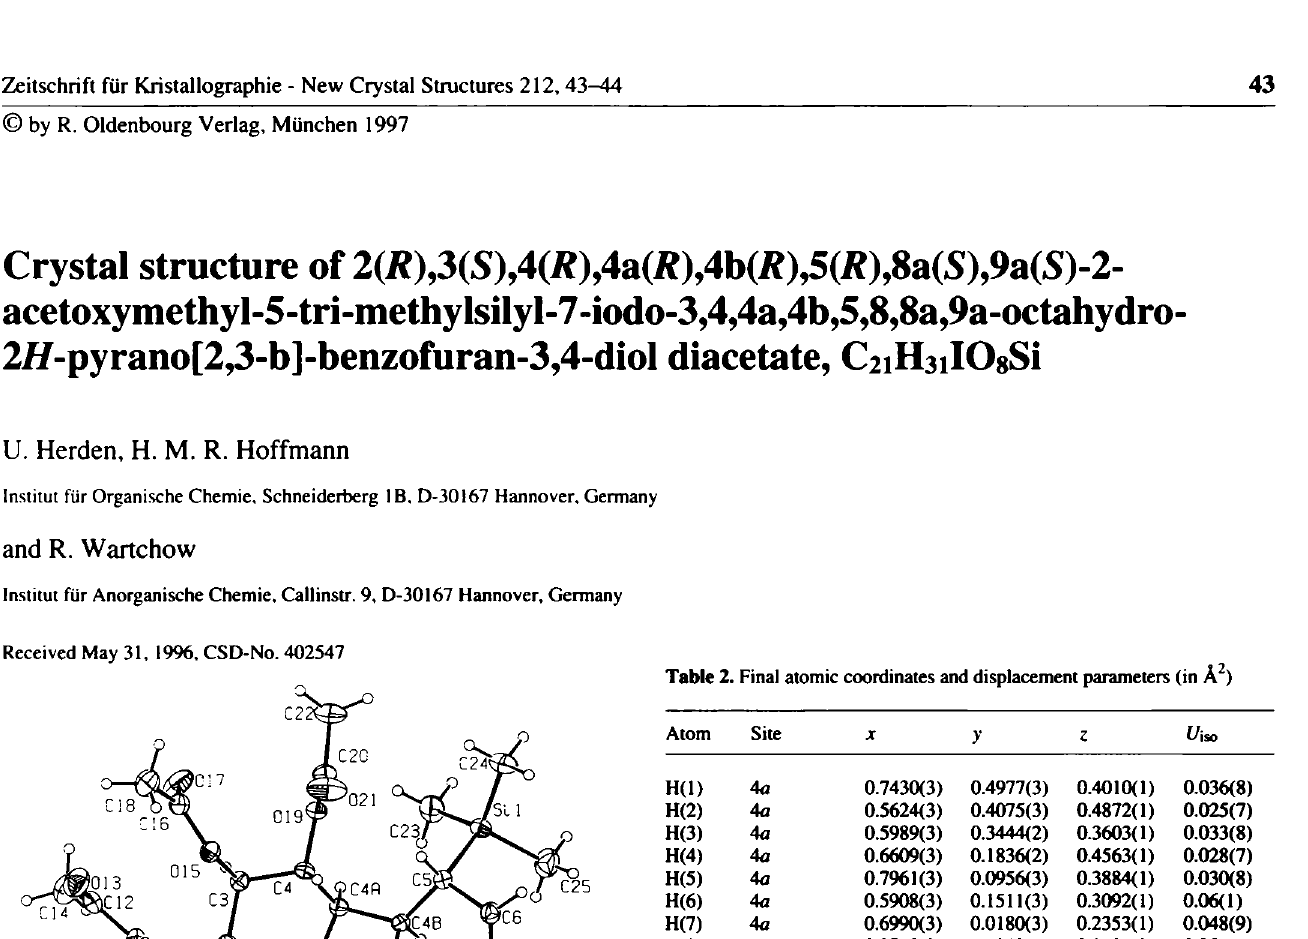
Table I. Parameters used for the X-ray data collection